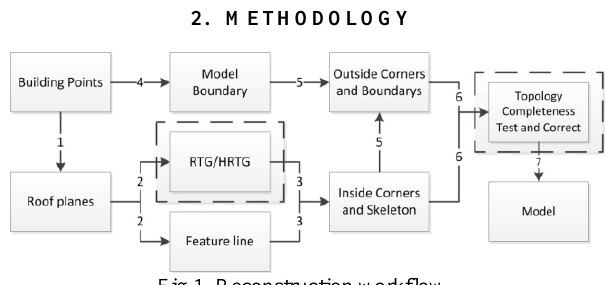
Fig 1. Reconstruction